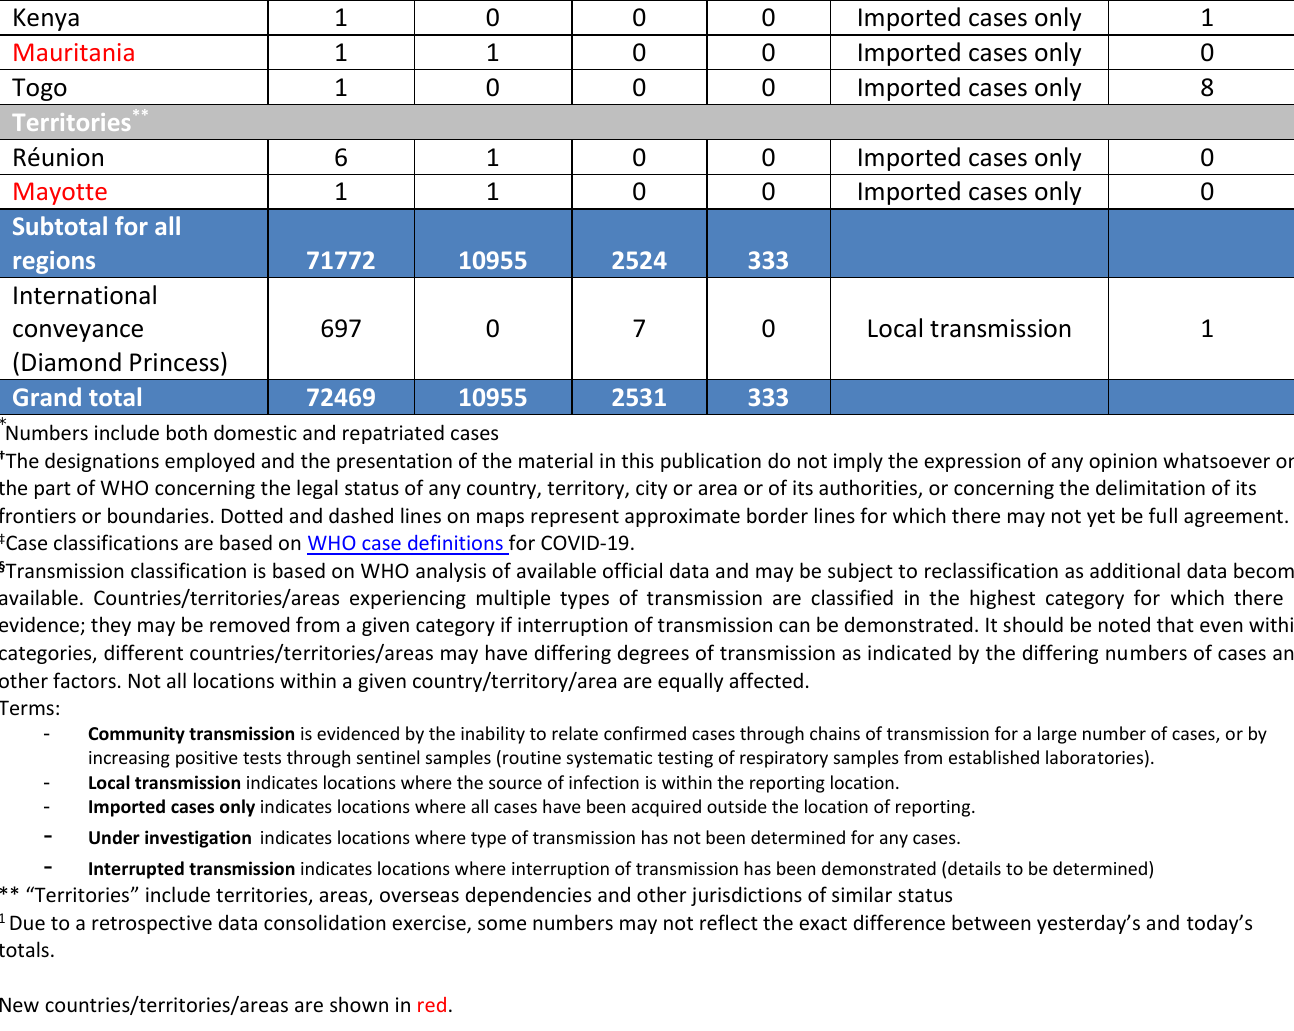
Figure 2. Epidemic curve of confirmed COVID-19 cases reported outside of China (n=72 469), by date of report